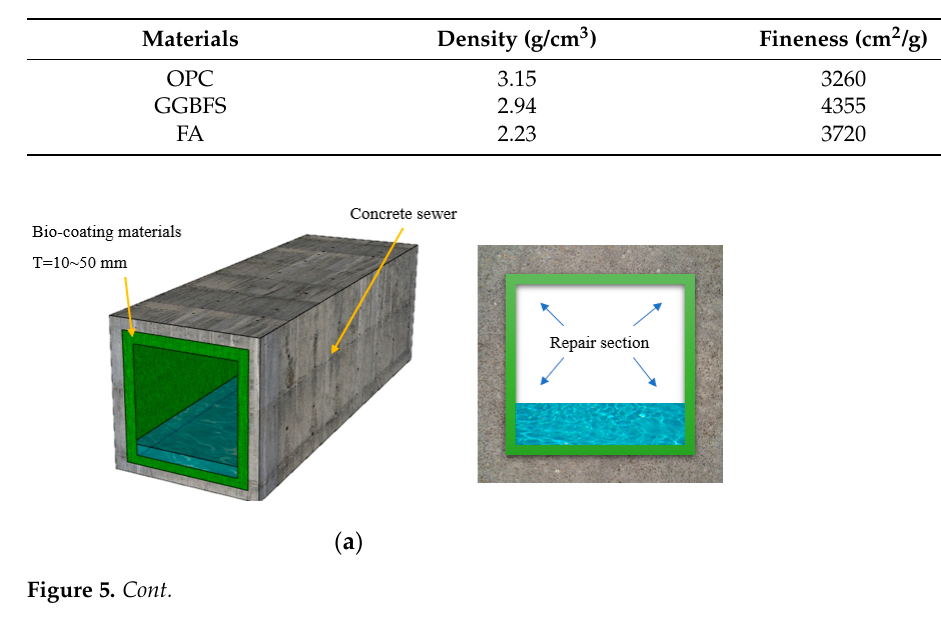
Table 5. Physical properties of the used cementitious materials.